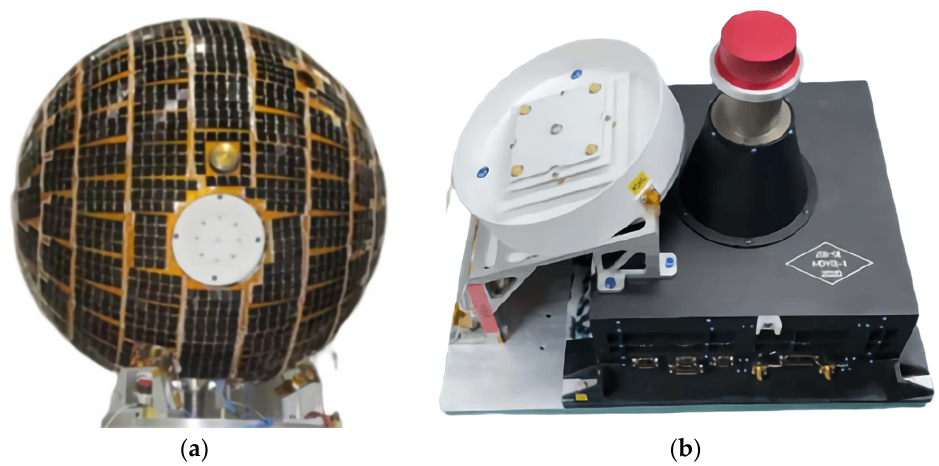
Figure 1. ( a ) QQ-Satellite structure; ( b ) High-precision GNSS receiver GPOD payload layout.